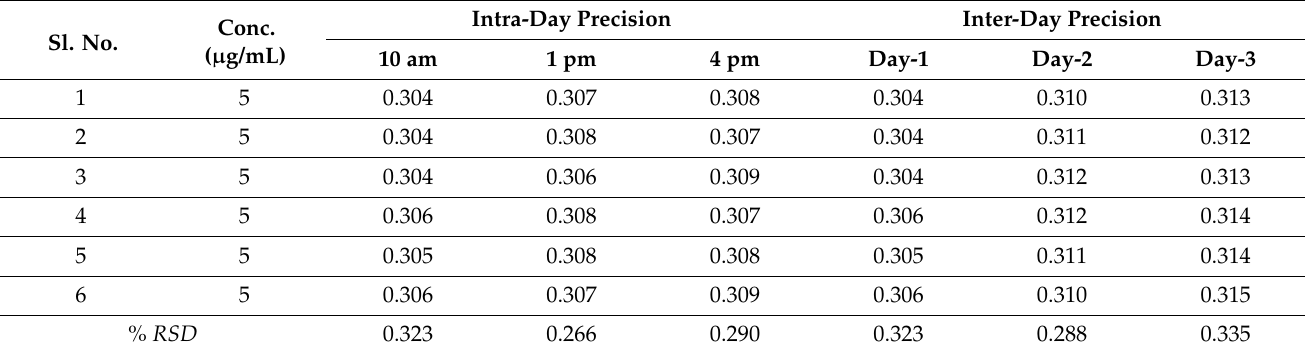
Table 2. Intra-day and inter-day reproducibility